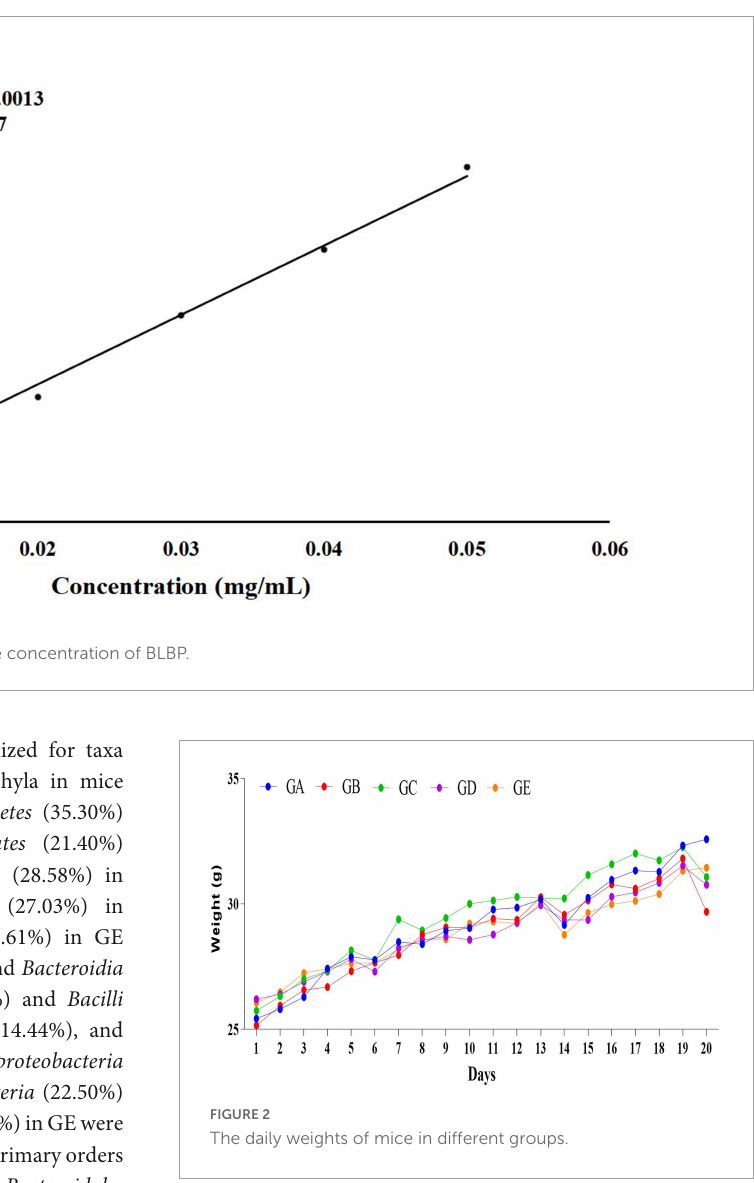
( Figure 7D ), and PCA demonstrated that species diversity difference in group GB compared